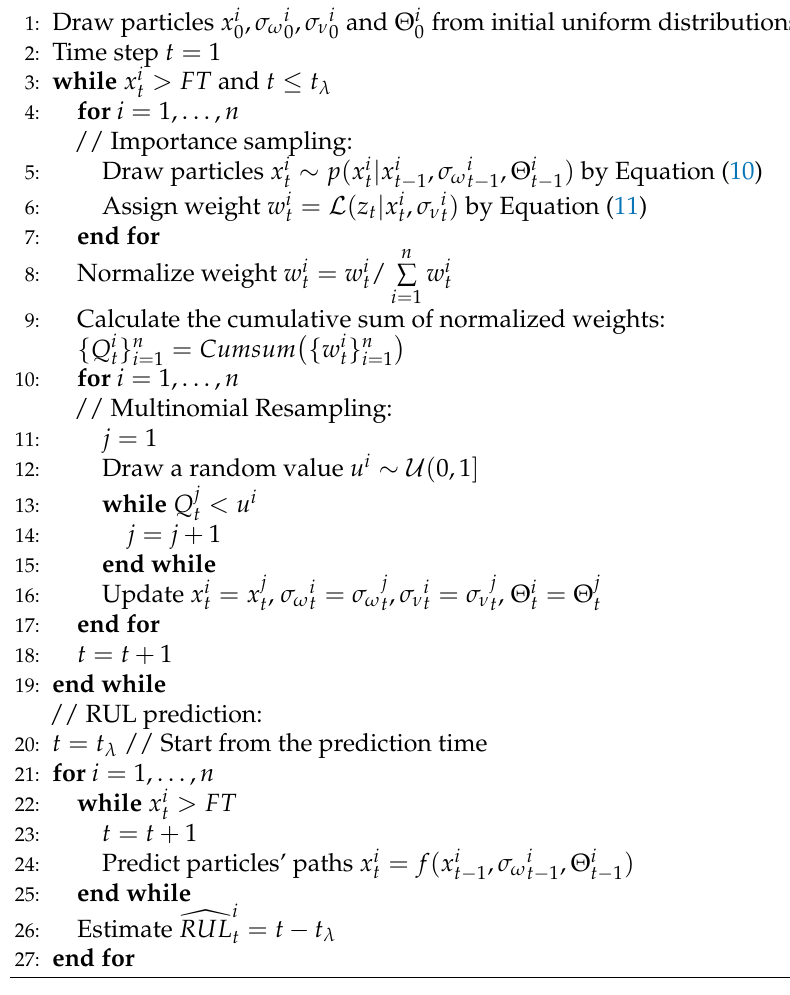
Algorithm A1 Particle Filtering-based RUL